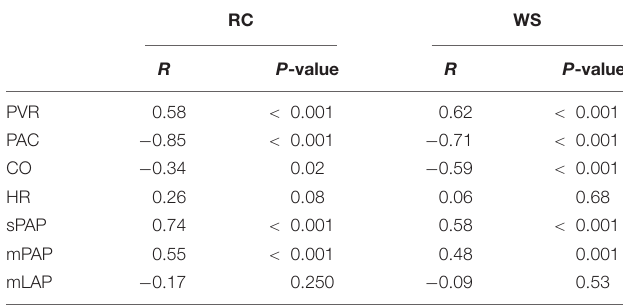
TABLE 3 | Hemodynamic determinants of Doppler-derived wave reflection indices.